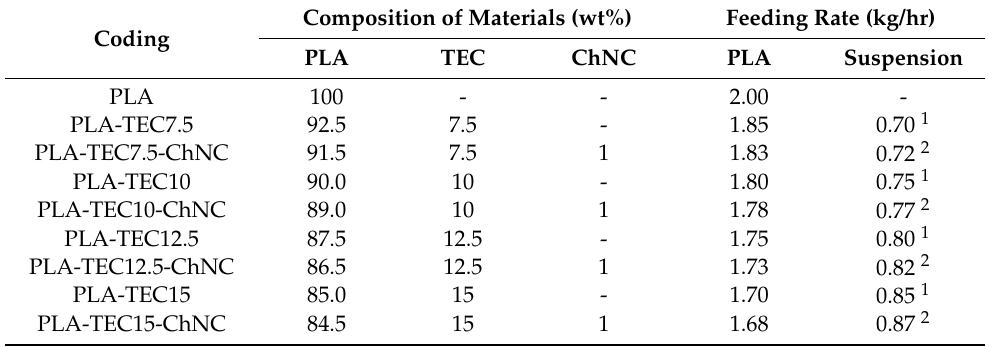
Table 6. Parameters for the liquid-assisted extrusion process and composition of the targeted materials. Composition of Materials (wt%) Feeding Rate (kg/hr) Coding PLA TEC ChNC PLA Suspension PLA 100